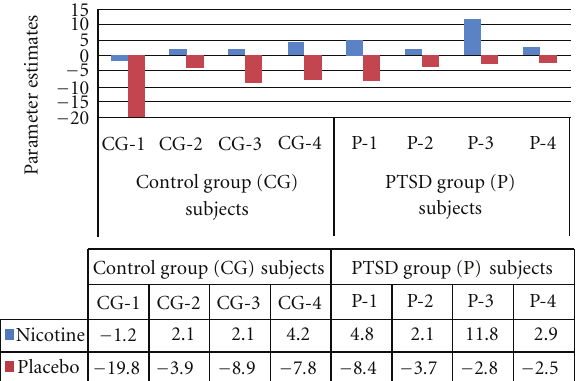
Figure 3: Model parameter estimates of the main e ff ect of patch type on task-related left caudate ( x = − 10, y = 14, z = − 6) BOLD response.